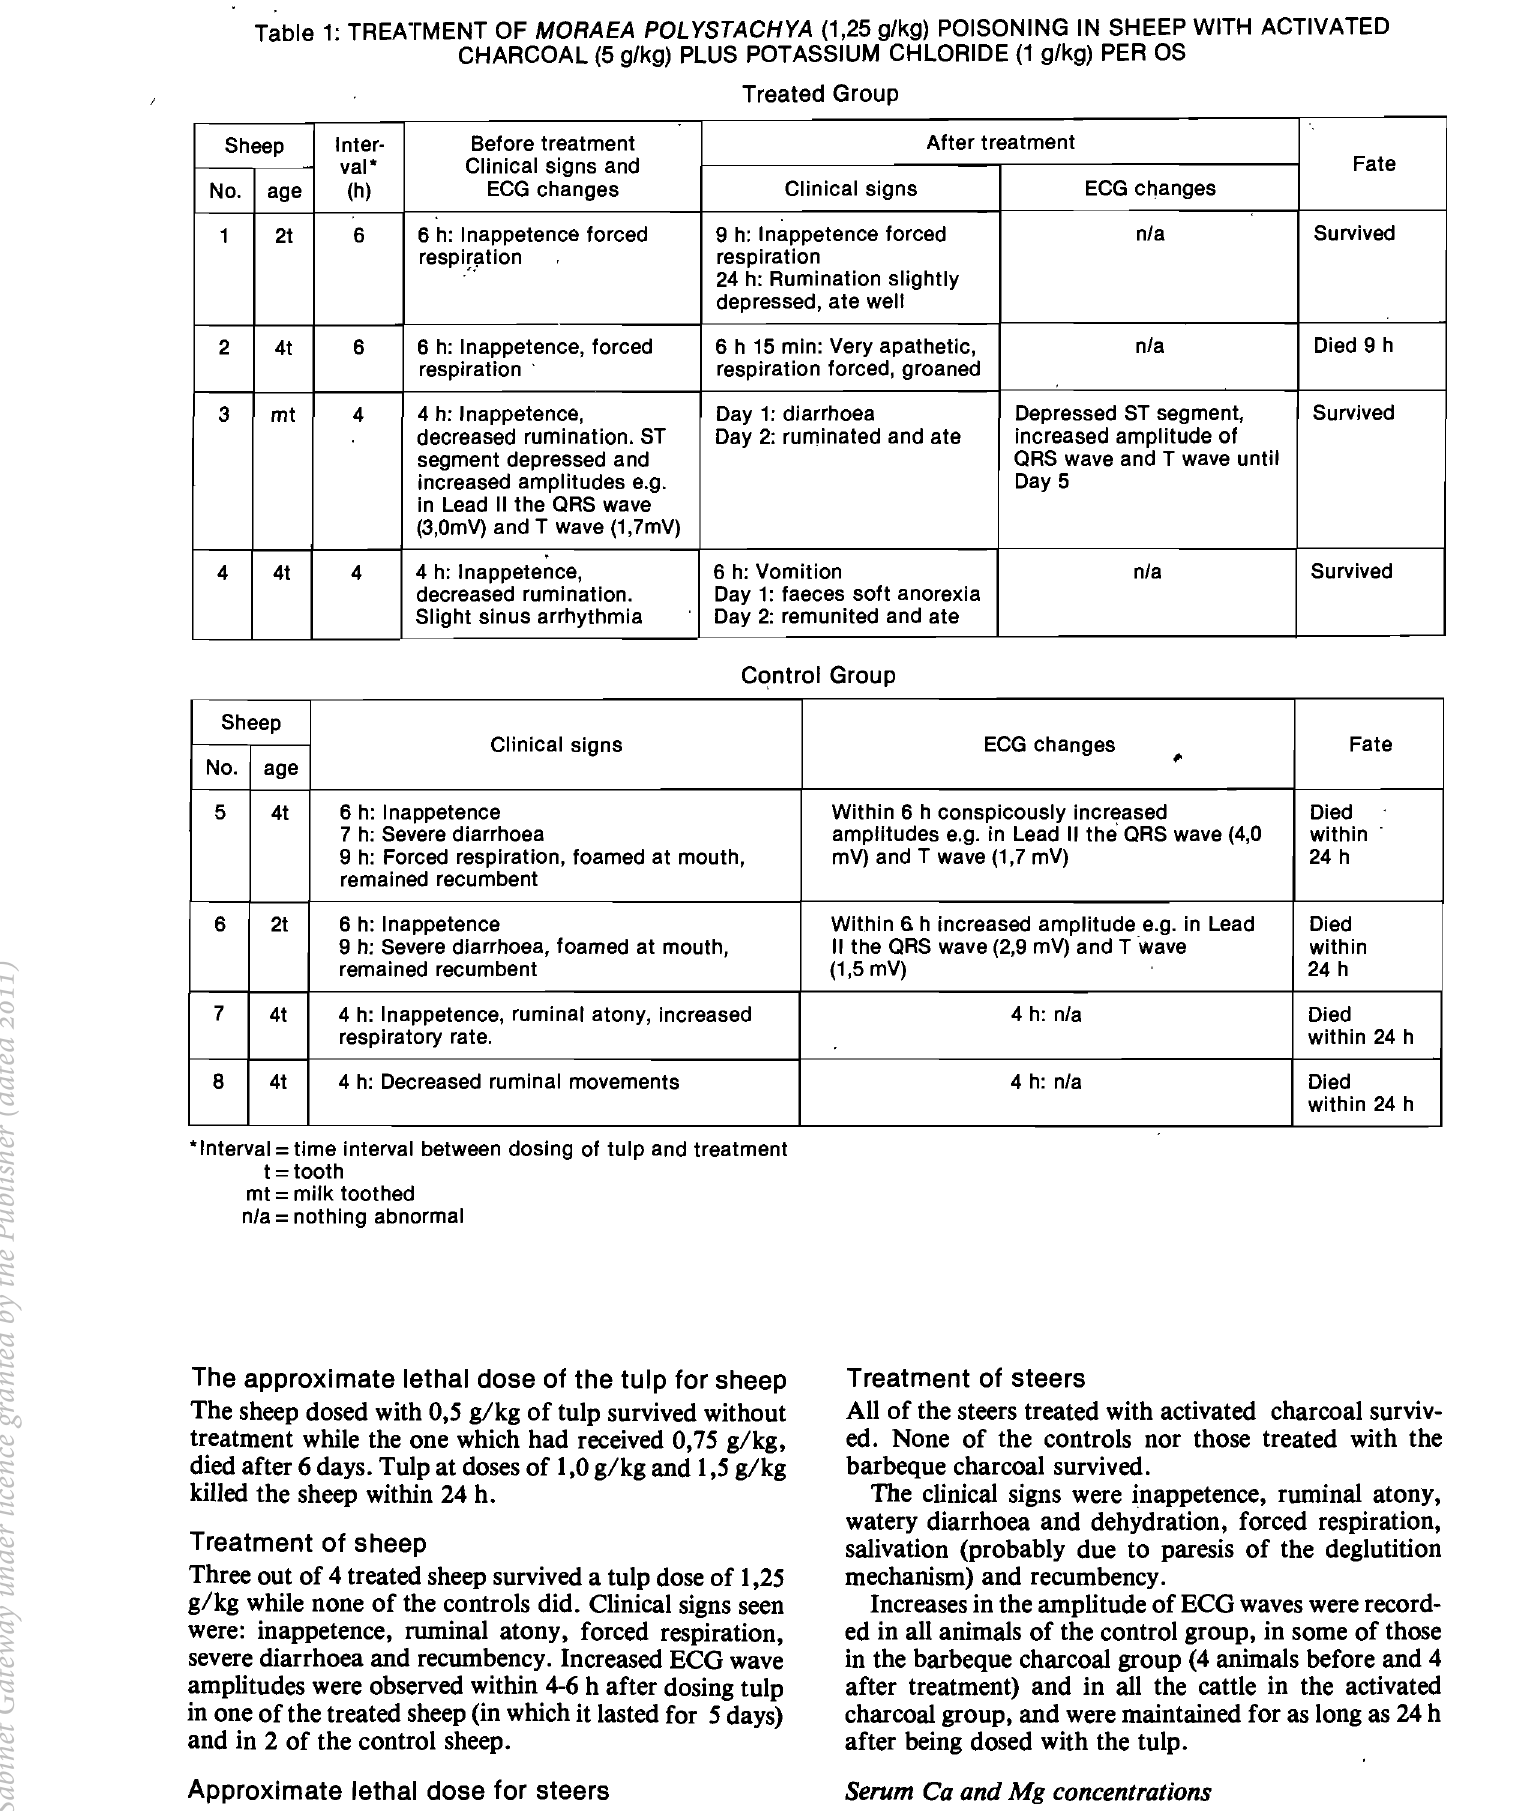
Table 1: TREATMENT OF MORAEA POLYSTACHYA (1,25 g/kg) POISONING IN SHEEP WITH ACTIVATED CHARCOAL (5 g/kg) PLUS POTASSIUM CHLORIDE (1 g/kg) PER OS Treated Group